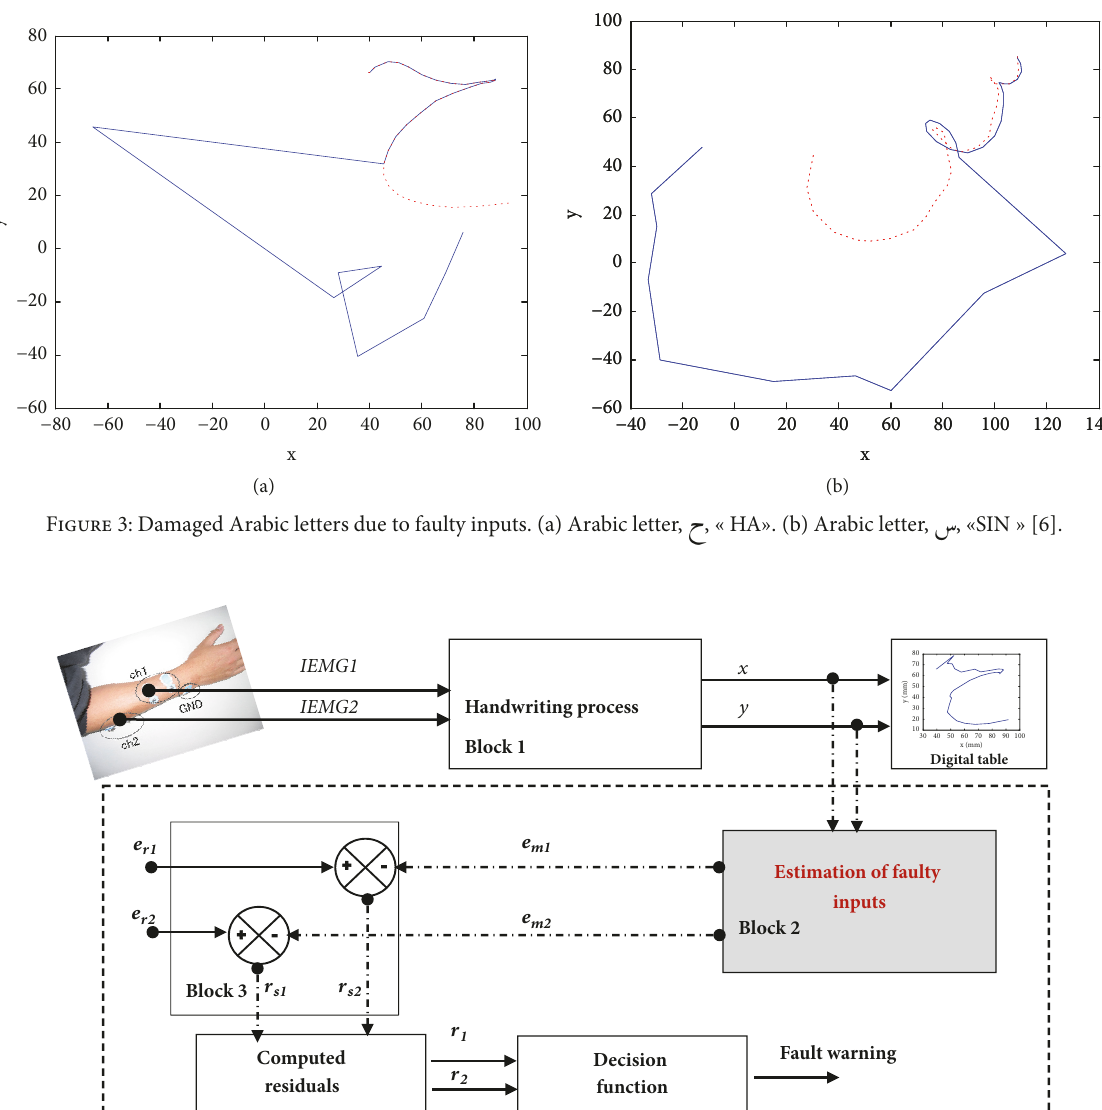
Figure 4: Synoptic schema of the proposed fault detection